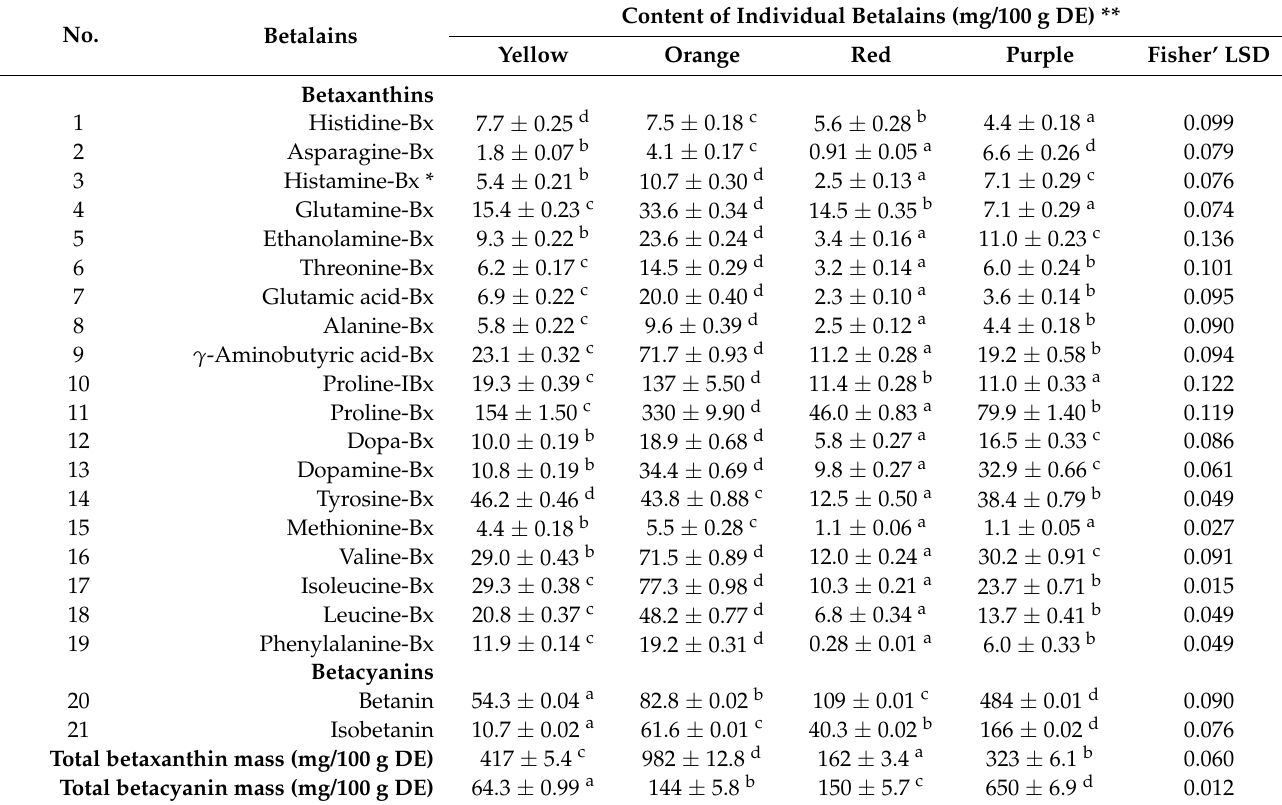
Table 1. Content of individual betalains and total betalains identified by HPLC-DAD-ESI-MS in the flowers of yellow, orange, red and purple P. grandiflora .